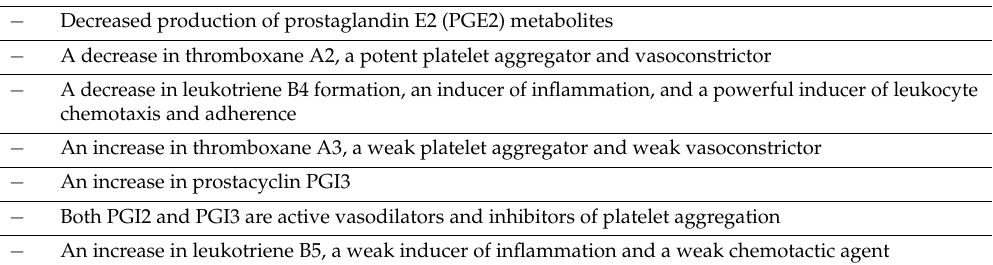
Table 1. Effects of Ingestion of eicosapentaenoic acid (EPA) and docosahexaenoic acid (DHA) from Fish or Fish Oil. Modified from [3].